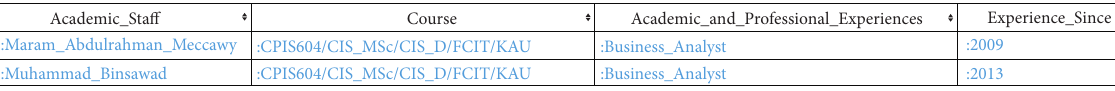
Figure 13: The query result of academic and professional experiences after